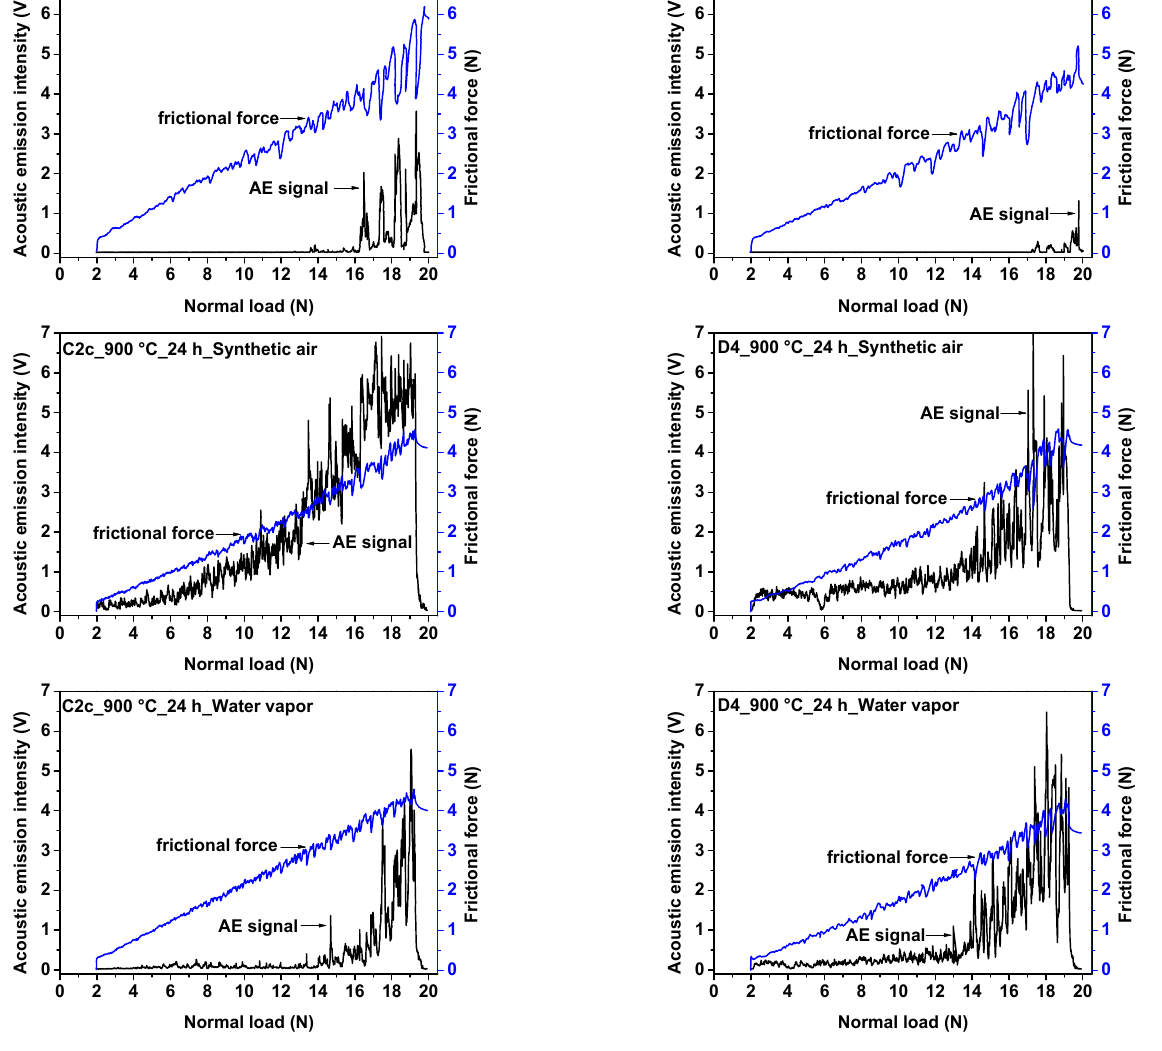
Figure 2. The dependence of acoustic emission signal and frictional force on the normal load during scratch tests of C2c and D4 coatings before and after oxidation tests (48 h at 900 °C).